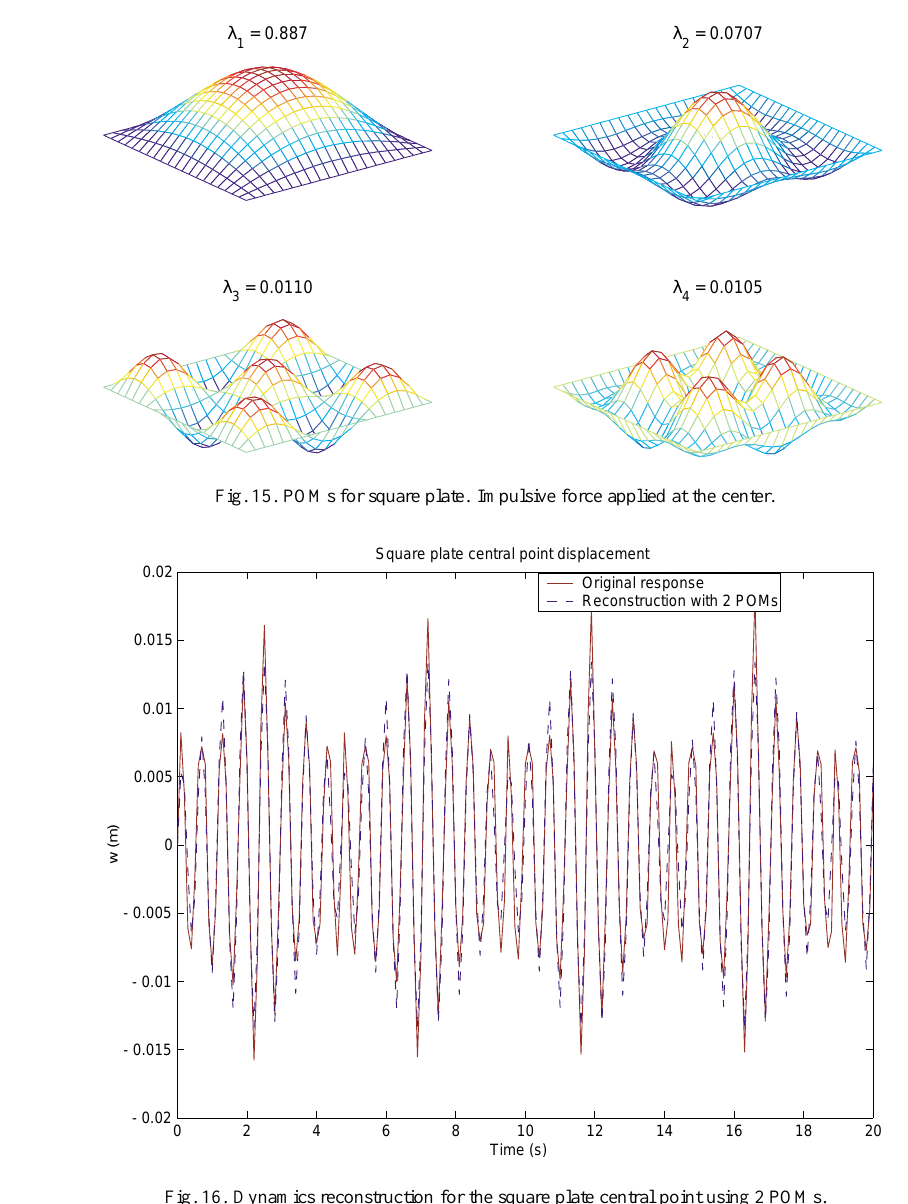
Fig. 16. Dynamics reconstruction for the square plate central point using 2